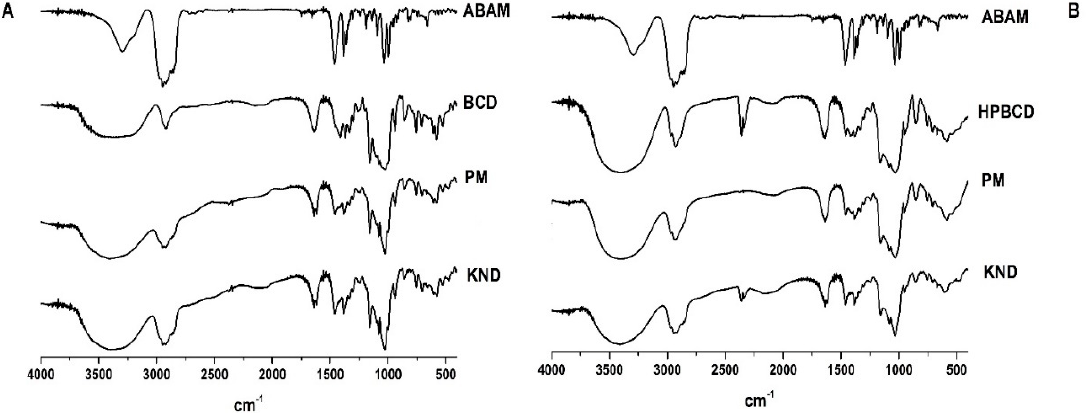
Figure 1. Fourier transform infrared (FT-IR) spectra of α , β amyrin (ABAM), β -cyclodextrin ( β CD), hydroxypropyl- β -cyclodextrin (HP β CD), and the corresponding inclusion complexes (ICs) obtained with β CD ( A ) and HP β CD ( B ) by physical mixture (PM) and kneading (KND) methods.